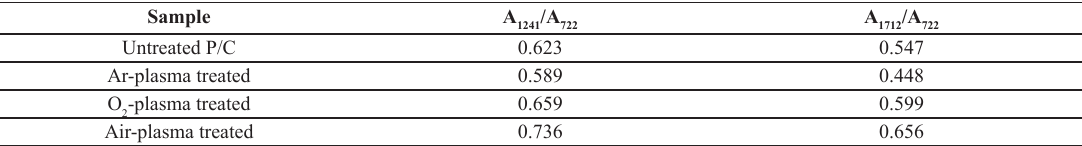
Table 6. The absorbance ratio on P/C blend fabric surface